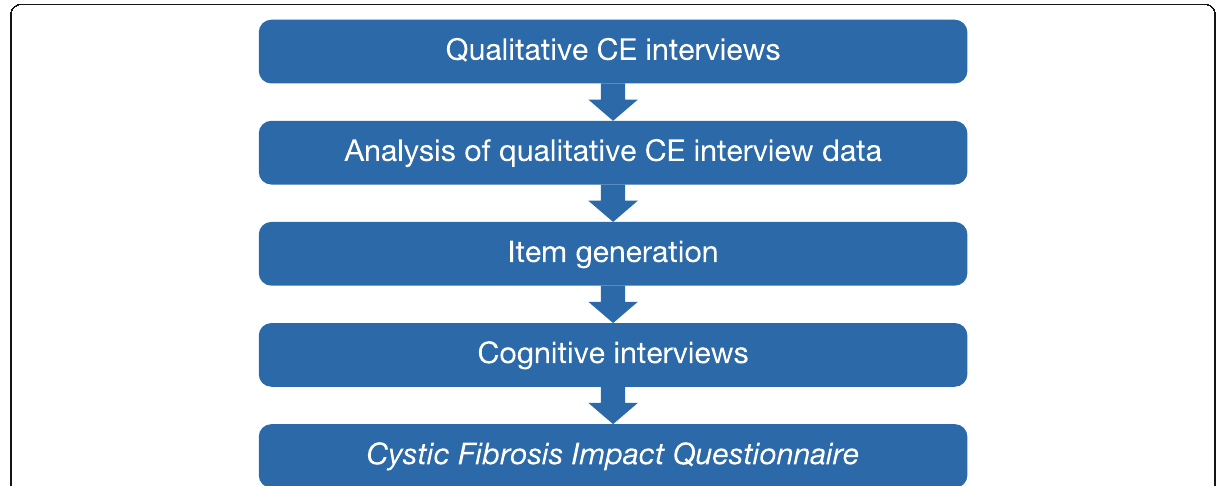
Fig. 1 Process flow chart for development of the Cystic Fibrosis Impact Questionnaire. CE concept